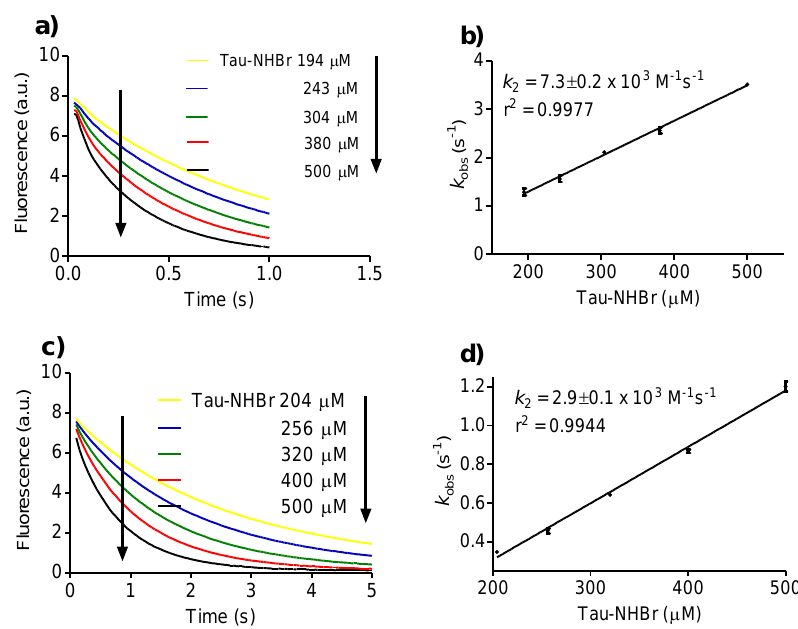
Figure 2. Reactivity of Tau-NHBr with melatonin and serotonin. Kinetic profile of ( a ) Melatonin and ( c ) Serotonin consumption for determination of k obs under pseudo-first-order experimental conditions. The reaction mixture was composed of 25 µM indoles and increasing concentrations of Tau-NHBr in 50 mM phosphate buffer, pH 7.0 at 25 °C. The stopped-flow system was set as follows: excitation, 280 nm LED; and emission, 325 nm cut-off filter. Determination of the bimolecular rate constant ( k 2 ) for the reaction between ( b ) Melatonin and ( d ) Serotonin with Tau-NHBr. The results are the mean of three experiments.